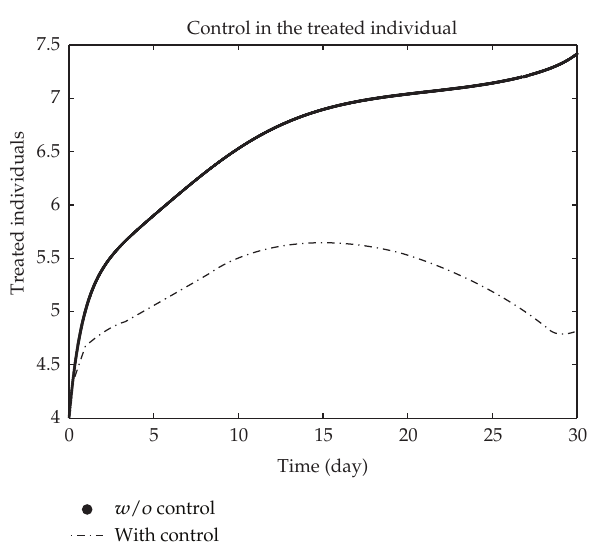
Figure 5: The plot represents the population of treated class with and without control.